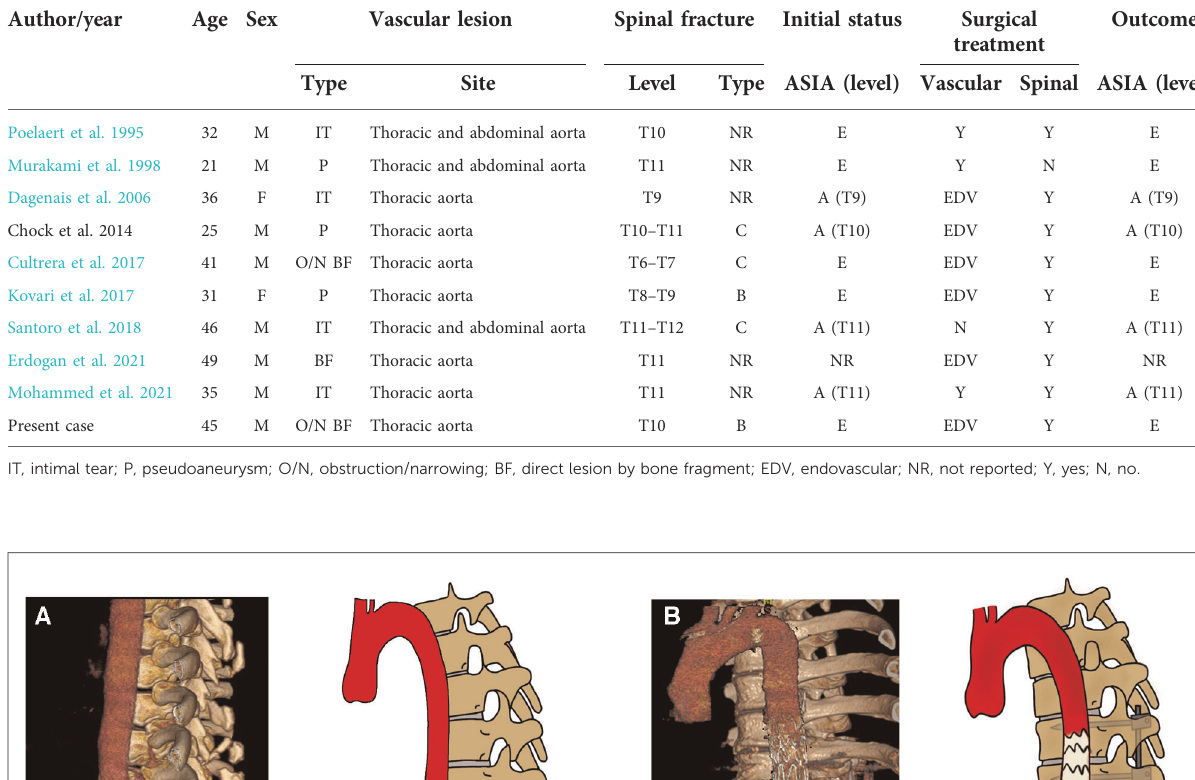
TABLE 1 Summary of 9 cases of aortic injury combined with thoracolumbar fracture identi fi ed by a literature search with addition of our case.